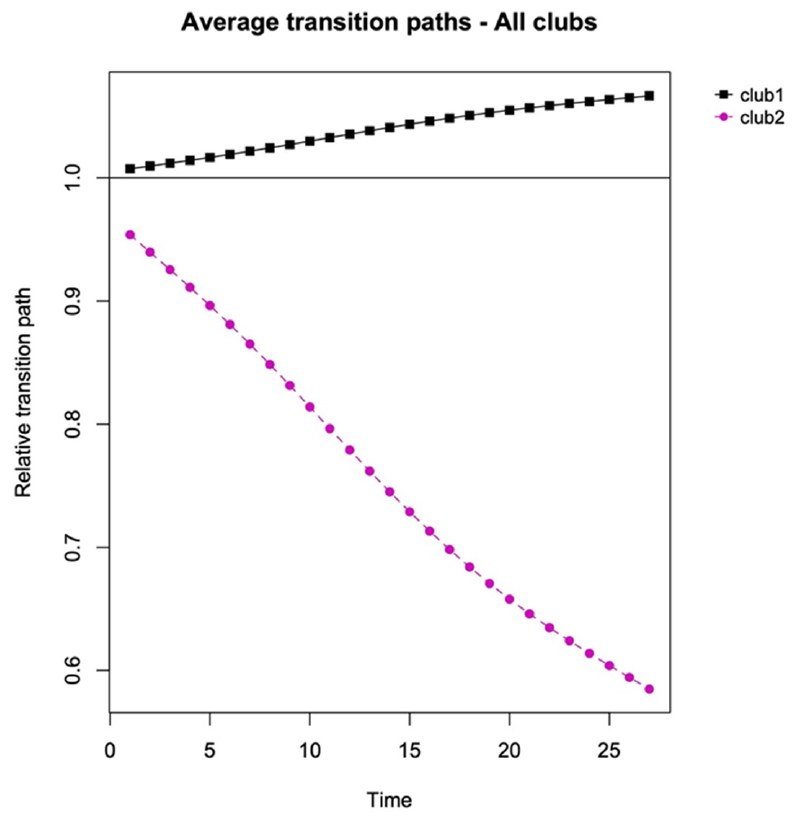
Figure 2. Average transition paths for Club 1 and Club 2. Source: authors’ research. We can notice ultimate green growth convergence for Club 1 as previously explained (average transition path close to unity). For the second convergence club, the average relative transition paths are declining, still supporting the convergence hypothesis in green growth (Club 2). Figure 3 displays an apparent convergence in relative transition path (country and average) and the difference in green growth convergence between the two clubs. Figure 2 lists countries sharing the same green growth convergence. Study results show green growth (among the countries in the sample) is characterized by two distinct steady-state paths (two convergence clubs with each separate steady state). Thus, our results support the hypothesis of converging pattern to a common (green growth) production-based CO 2 productivity (GGDP) level. Club 1 lists the countries that have the same dynamics of convergence in green